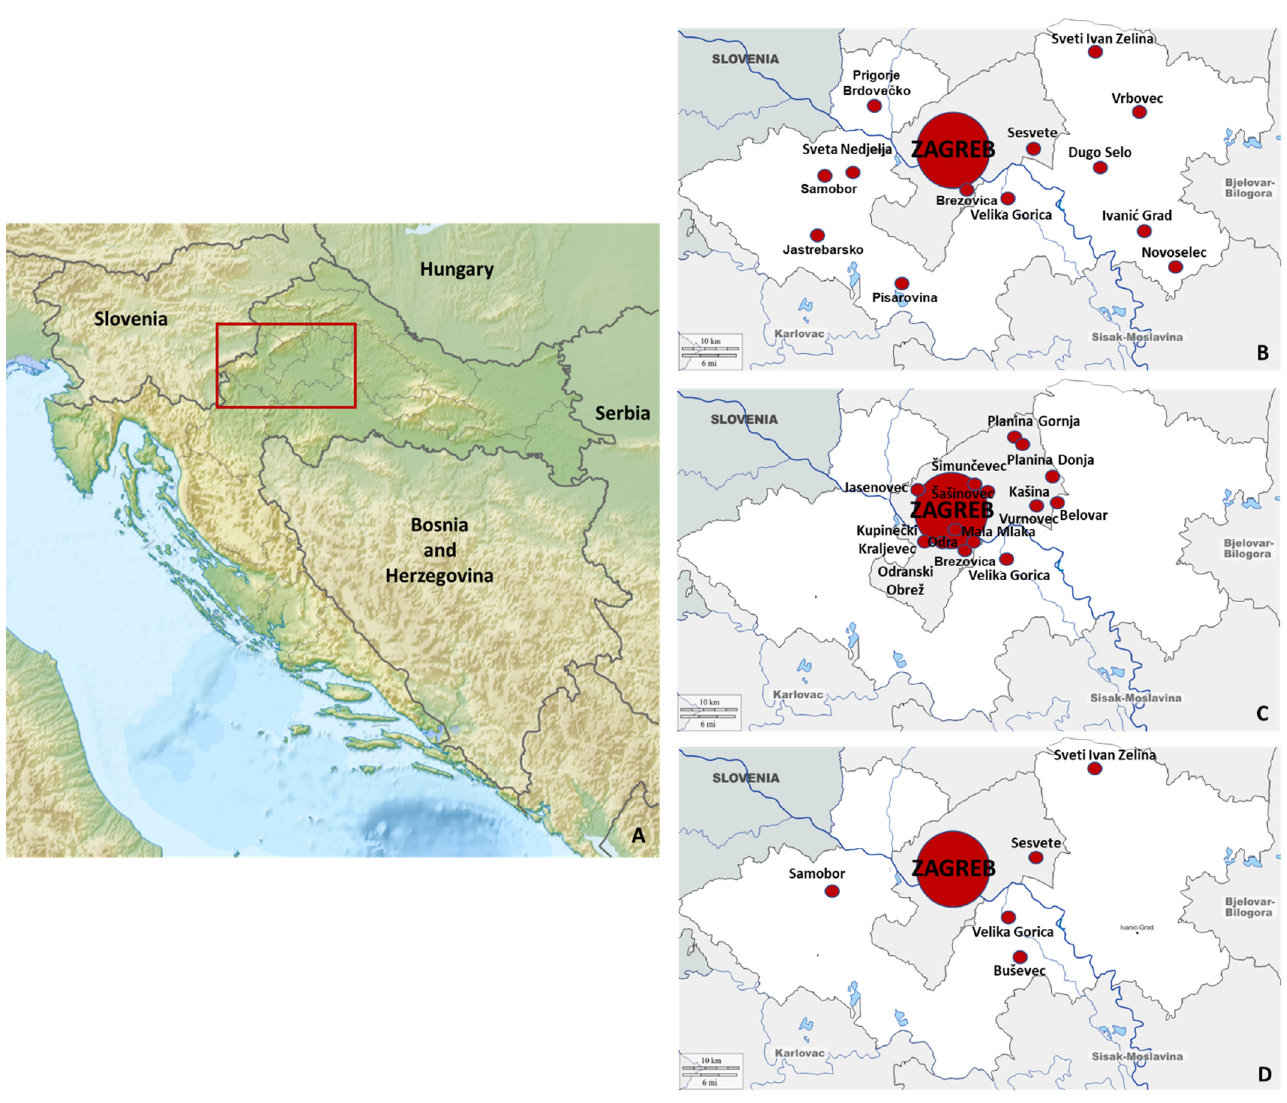
Figure 1. Sampling area in continental Croatia ( A ): human ( B ), horse ( C ), and pet animals ( D ) sam- pling areas.